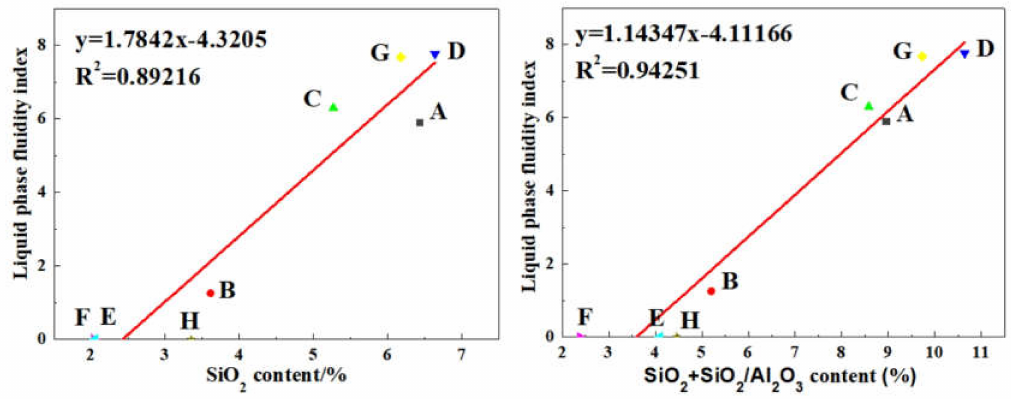
Figure A3. Correlation between chemical compositions and liquid phase fluidity of iron